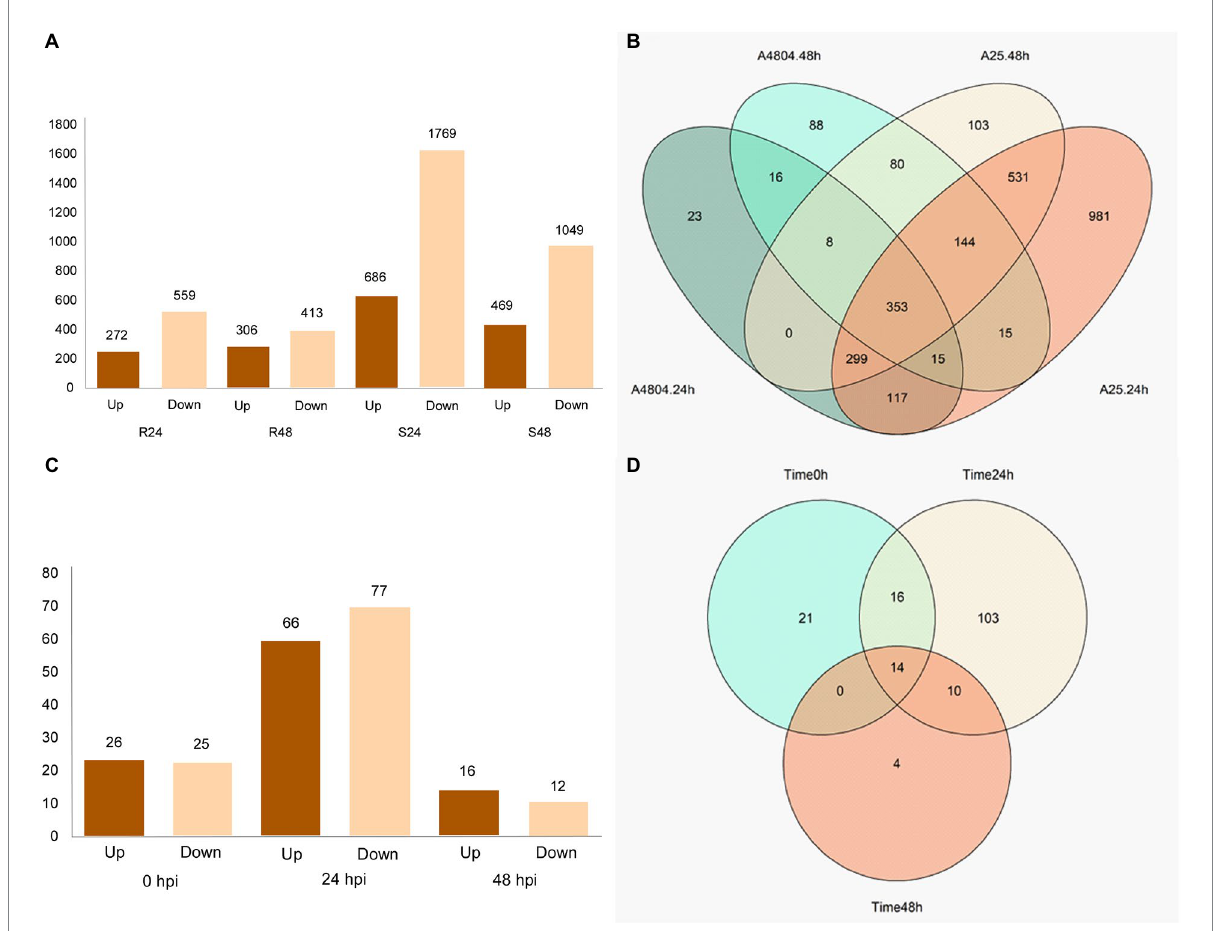
FIGURE 2 Visualization of DEGs detected from comparison at different hpi and between genotypes in the same hours post-inoculation (hpi). (A) Histograms showing the number of DEGs, upregulated and downregulated, at different hpi in the two genotypes (B) Venn diagrams showing the numbers of specific and common DEGs at different hpi in the two genotypes. (C) Histograms showing the number of DEGs, upregulated and downregulated, at the same hpi. (D) Venn diagrams showing the numbers of specific and common DEGs at different